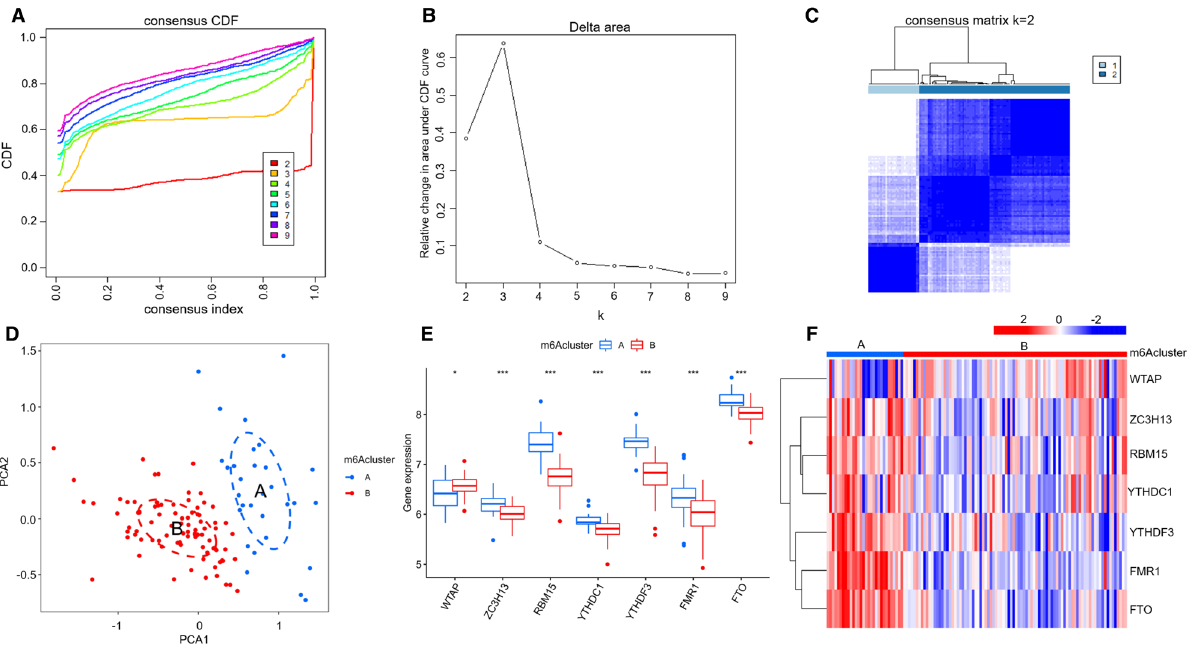
Figure 4. Identification of two distinct m6A modification pattern subtypes in ICM. ( A ) Consensus clustering cumulative distribution function (CDF) for k = 2–9. ( B ) Relative changes in the area under the CDF curve for k = 2–9. ( C ) Heatmap of the matrix of the co-occurrence proportions in the ICM samples. ( D ) Principal component analysis of the transcriptome profiles of the two m6A subtypes, showing a remarkable difference in the transcriptome between the different modification patterns. The box plot ( E ) and heatmap ( F ) showing that the expression of seven m6A regulators were significantly different between the m6A-cluster-A and -B groups. *, P < 0.05; ***, P < 0.001.